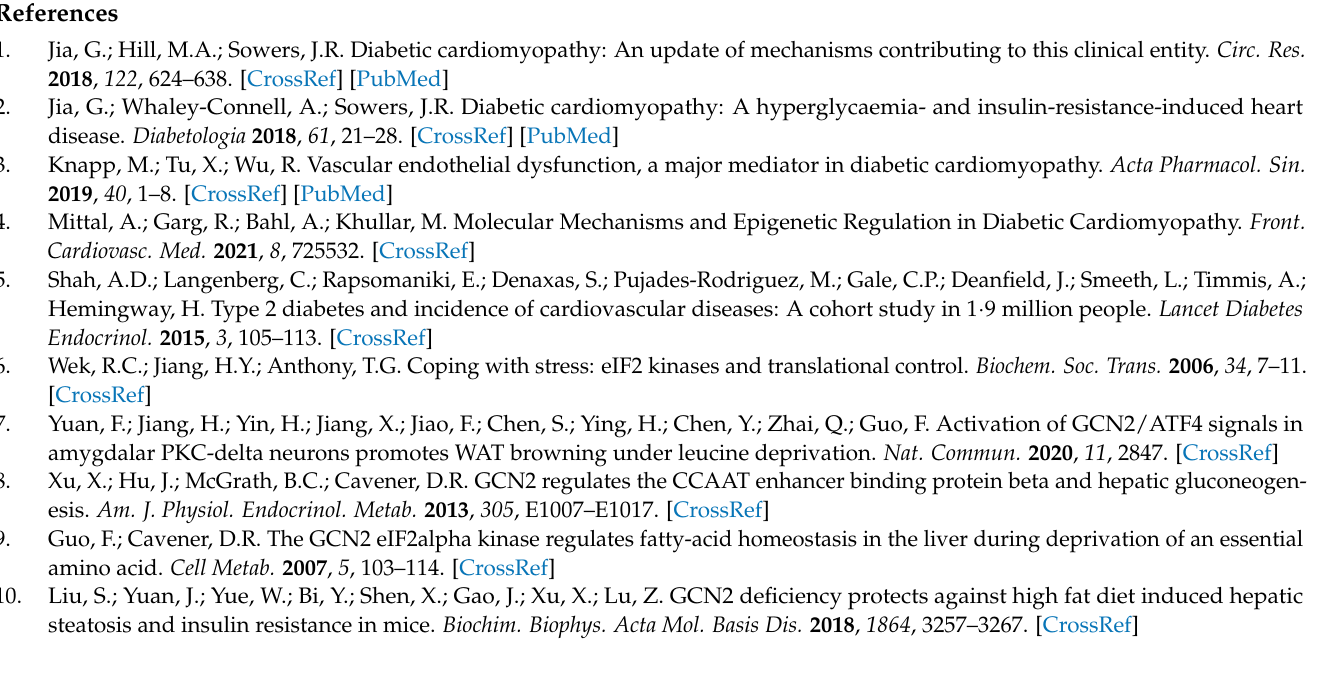
primer information; Table S2: Cardiac function data for oil- and GCN2iB-treated type 2 diabetic mice. Table S2: Cardiac function data for oil- and GCN2iB-treated db/db